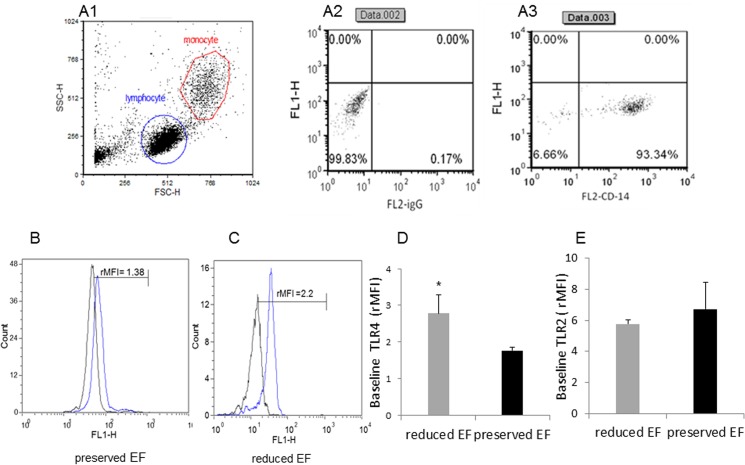
Dot plot and histograms representing TLR4 and TLR2 levels in monocytes.(A1-A3) Monocytes/lymphocyte cell population after CD14-positive cell staining. (B-C) Shift to the right demonstrating an increase in the amount of TLR4 staining in the monocytes. Specific mean fluorescence (MFI) can be quantified from these histograms for each case. (D) TLR4 levels on the population of monocytes as measured using relative mean fluorescence intensity (rMFI). (C) ‘reduced EF‘ patients (EF<45%) and ‘preserved EF‘ patients (EF>55%). (E) TLR2 levels on the population of monocytes as measured using rMFI. FACS analysis,* P<0.03 patient with ‘reduced EF’ TLR4 was higher than that of patients with ‘preserved EF’.